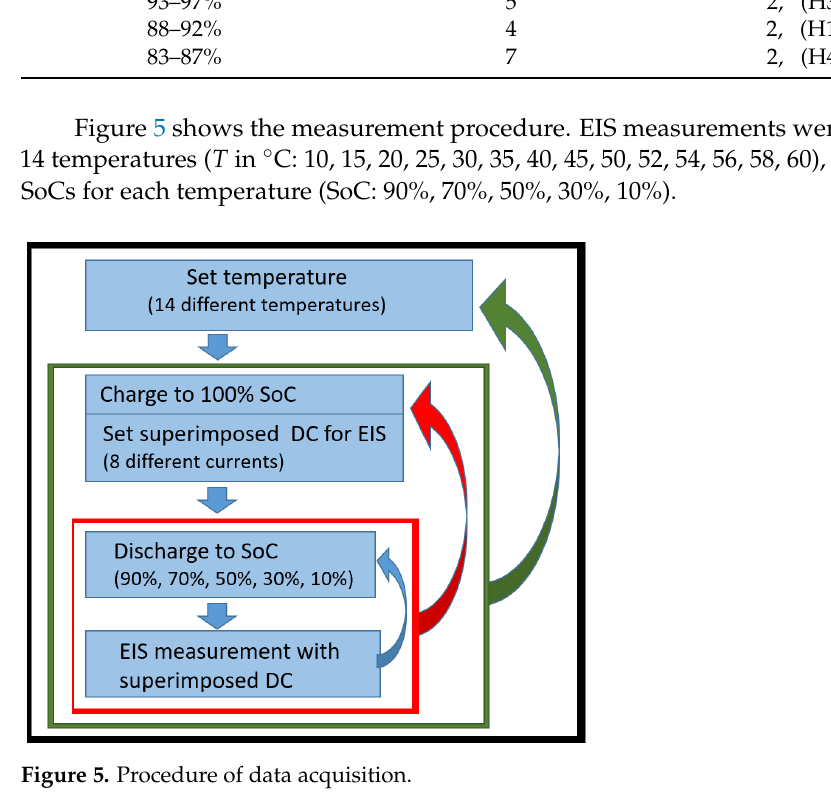
Table 2. State of health with respect to nominal capacity ( C / C N ). Thirty-six cells were investigated. For each SoHC range, the data of 2 cells were defined as test data; the data of the other cells were used as the training dataset for the neural network (ANN). This guaranteed that each SoHC range would be taken into account. The labels Hx refer to the investigated cells. Number of Cells Used for SoHC C / C N ANN Training ANN Test, (Cell Label) 98–102% 12 2, (H18, H38)